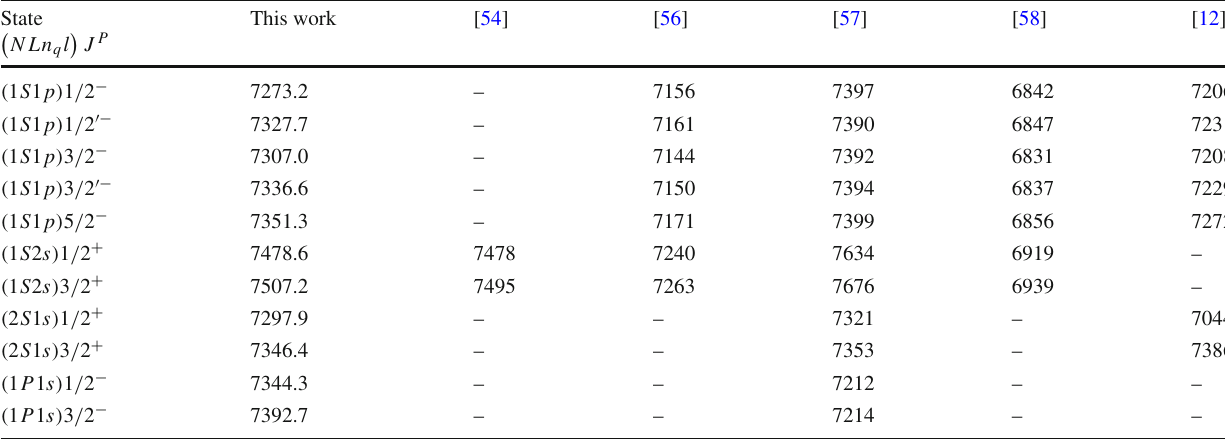
Table 12 Mass spectra(MeV) of (cid:2) bc baryons. Our results are obtained by the respective sum of the mean mass of the (cid:2) bc in Table 3, the binding energy shift(vanishes in 1S1s wave) in Table 9 and its splittings in Sect. 3 with the couplings given in Sect. 4